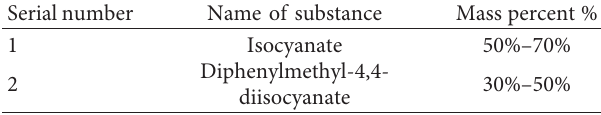
Table 1: WANNATEPM-200 composition.